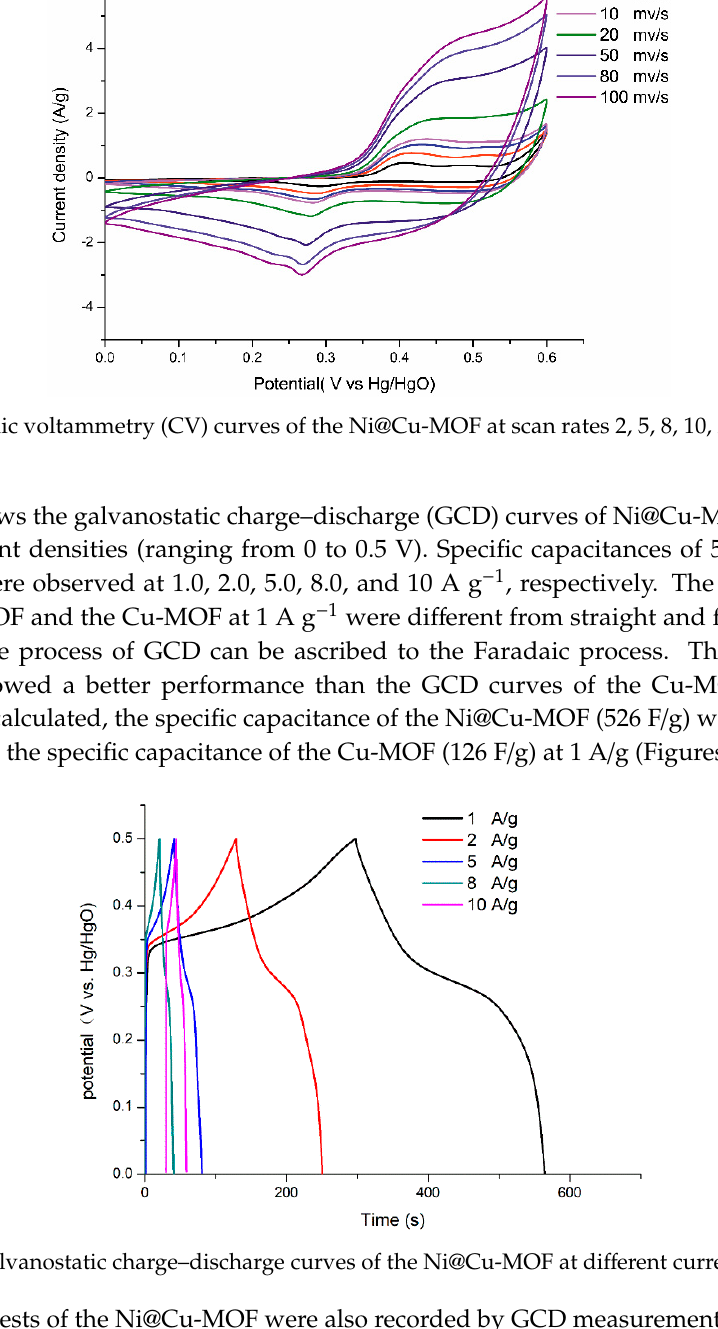
Figure 4. Galvanostatic charge–discharge curves of the Ni@Cu-MOF at different current densities.